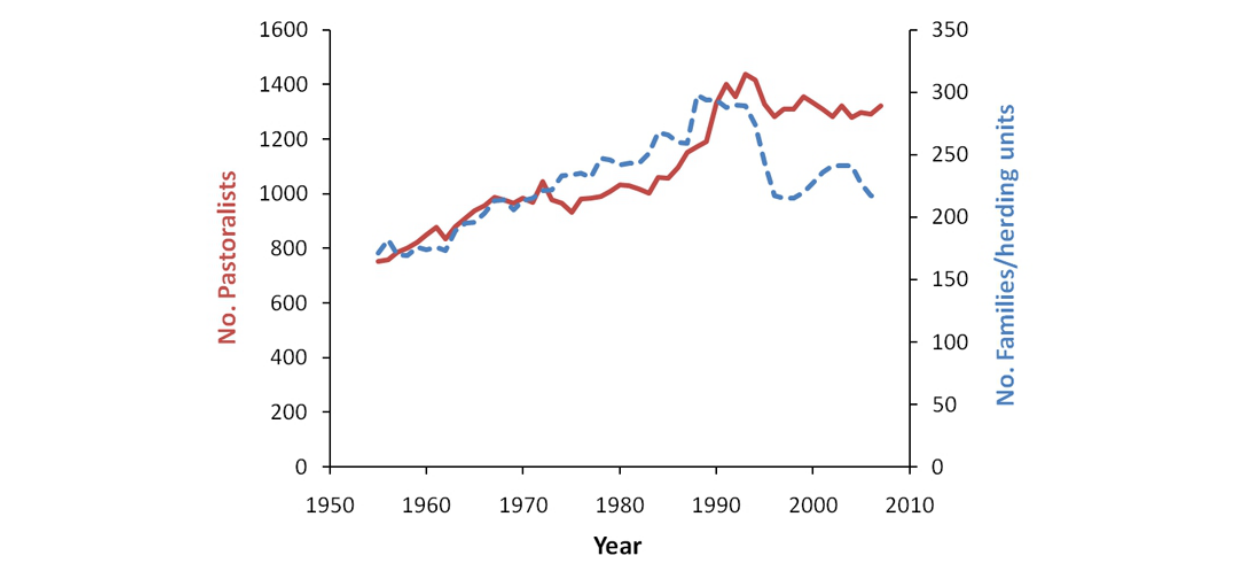
Fig. 2. Time course of the number of Saami families/herding units (hatched, blue) and number of pastoralists (solid,